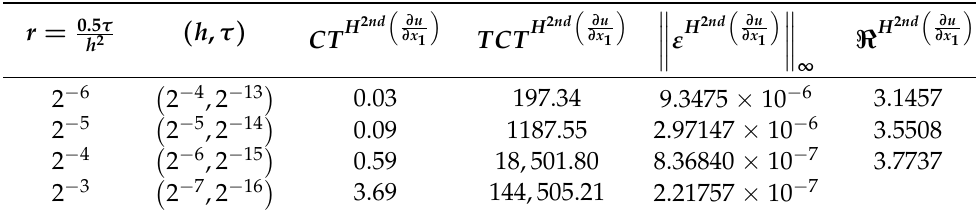
Table 2. Computational time, maximum norm of the errors, and the order of convergence of z h , τ to the exact derivative z = ∂ u r = 0.5 τ h